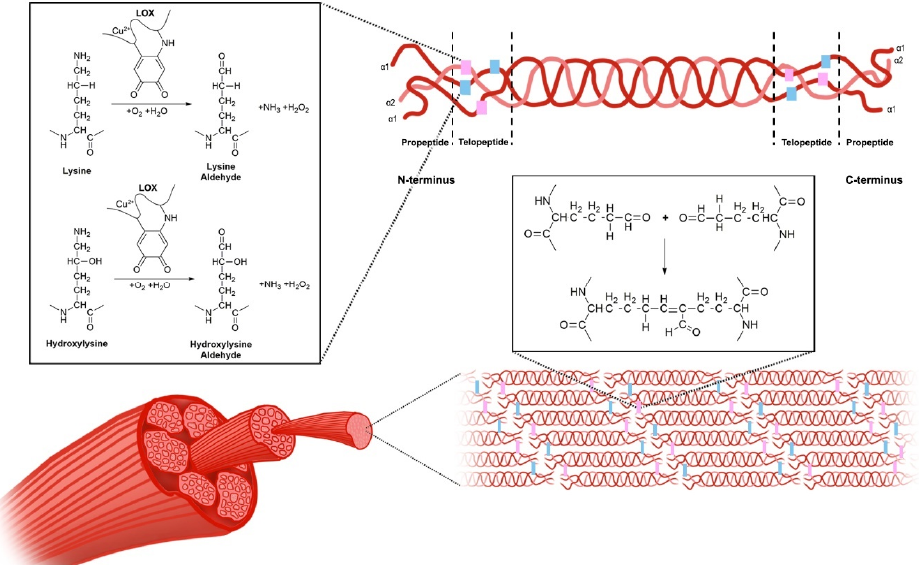
Figure 2. The mechanism of lyslyl oxidase collagen cross-linking. LOX catalyzes the conversion of lysine and hydroxylysine to lysine aldehyde and hydroxylysine aldehyde, respectively. This occurs within the telopeptide region of the procollagen molecules. The propeptide fragments of these molecules are then truncated to form tropocollagen molecules, which self-assemble and form cross-links, thereby forming collagen fibrils.